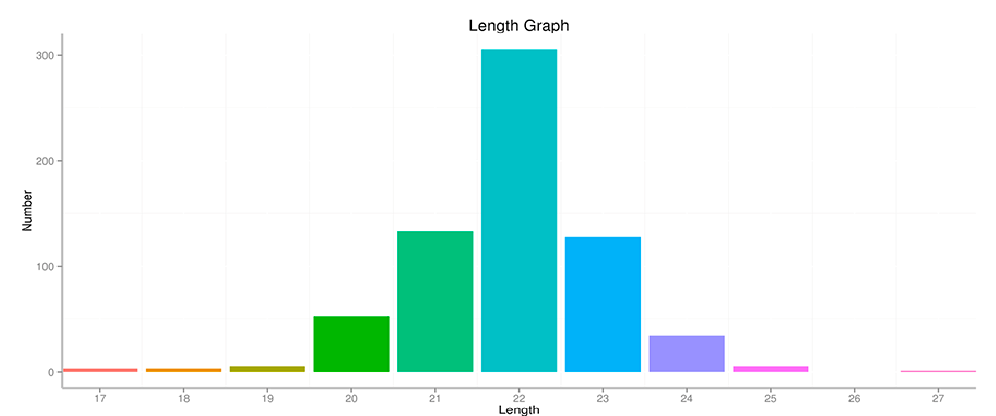
Figure 1. Length distribution of the sequences. (Different colors represent the distribution of miRNA length). Table 6. Distribution of small RNA among differently expressed categories in the library